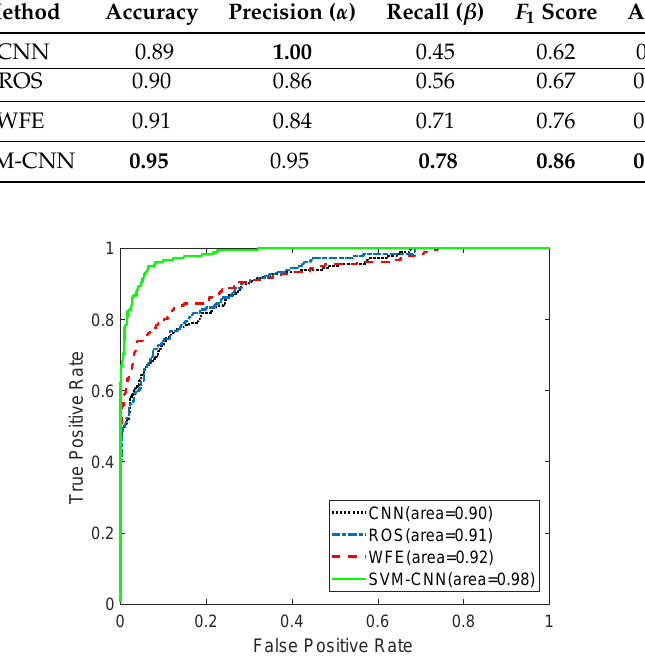
Figure 6. ROC curves in the mixed